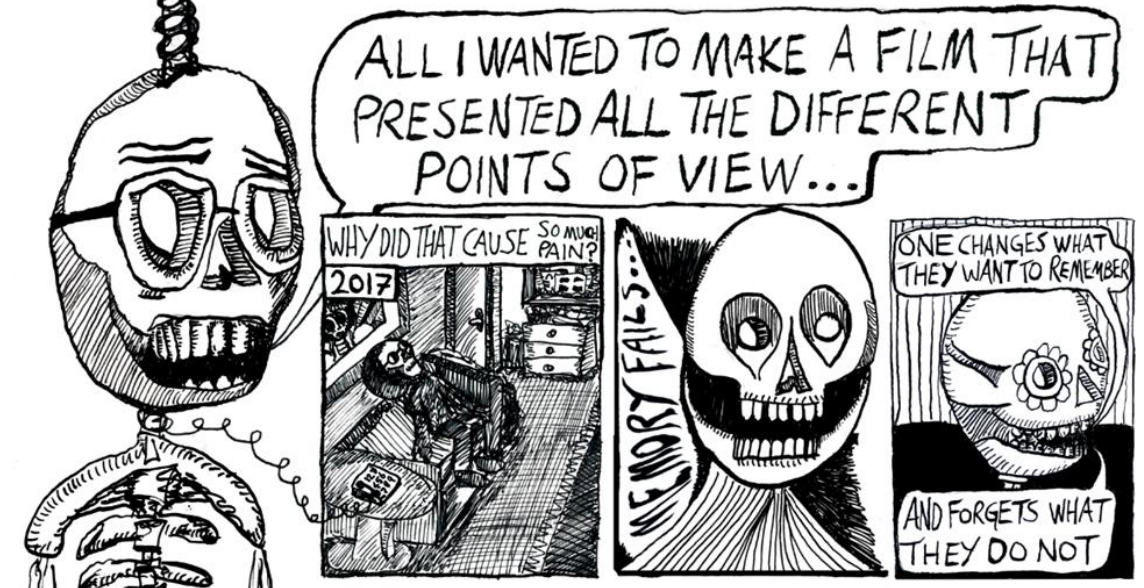
Figure 14: “All I wanted to make [sic] a film that presented all the different points of view (Sherwood Gonzalez 2022,